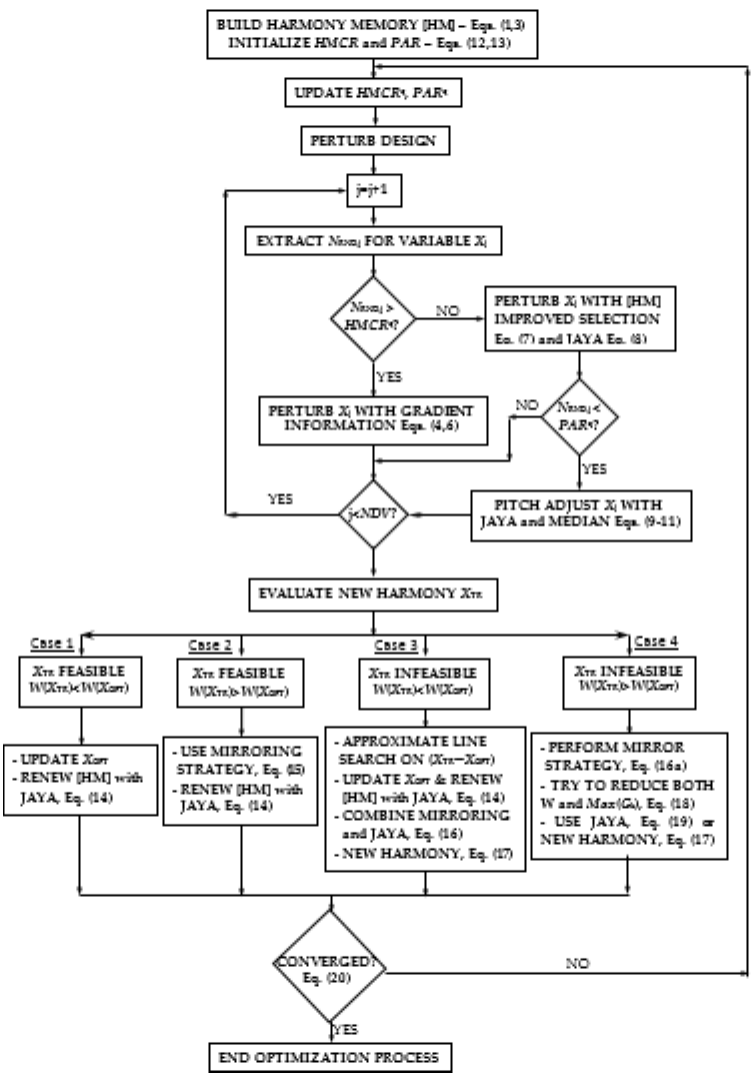
Figure 1. Flow chart of the hybrid LSSO-HHSJA algorithm developed in this research. Similar to [53], parameters HMCR and PAR are adaptively changed in the optimiza- tion process. The bw parameter also is not necessary as new trial designs always lie on descent